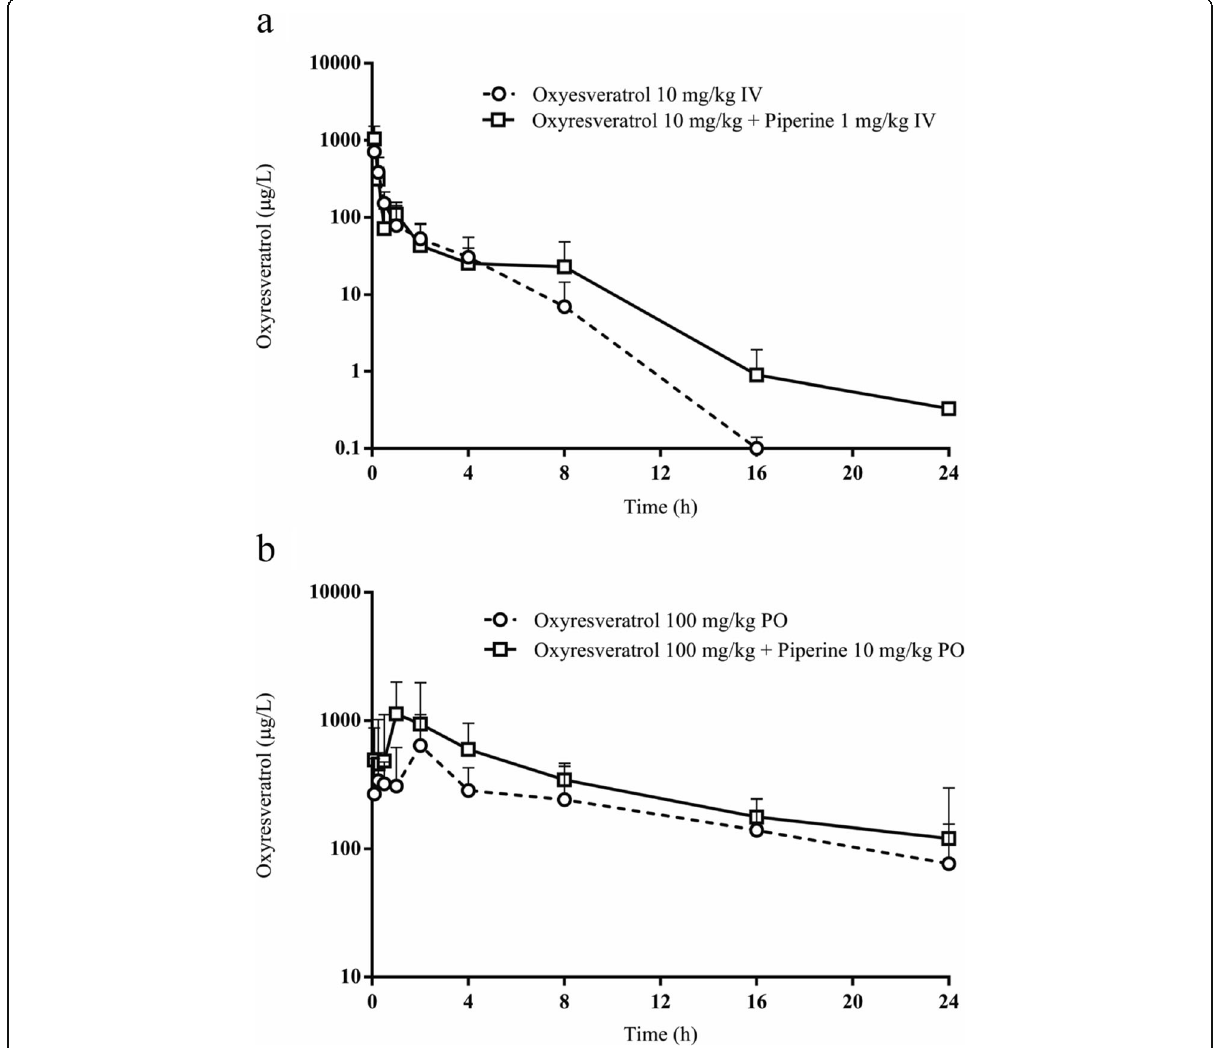
Fig. 2 Plasma concentration – time profile of oxyresveratrol after intravenous dose ( a ); after oral dose ( b